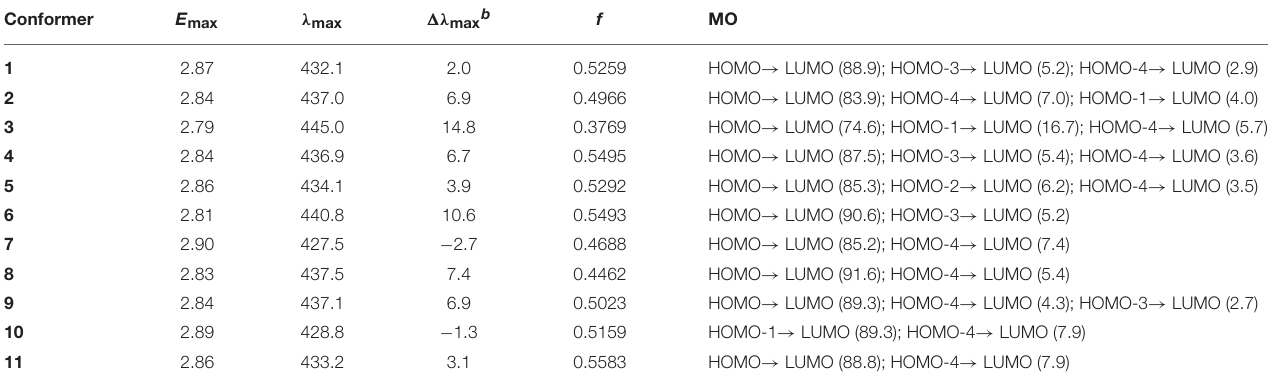
TABLE 6 | Vertical excitation energy ( E max ), maximum absorption wavelength ( λ max ), spectral shift ( 1λ max ), oscillator strength f and MO contribution (%) for the 11 conformers (energy and wavelength are in eV and nm, respectively) a . Conformer